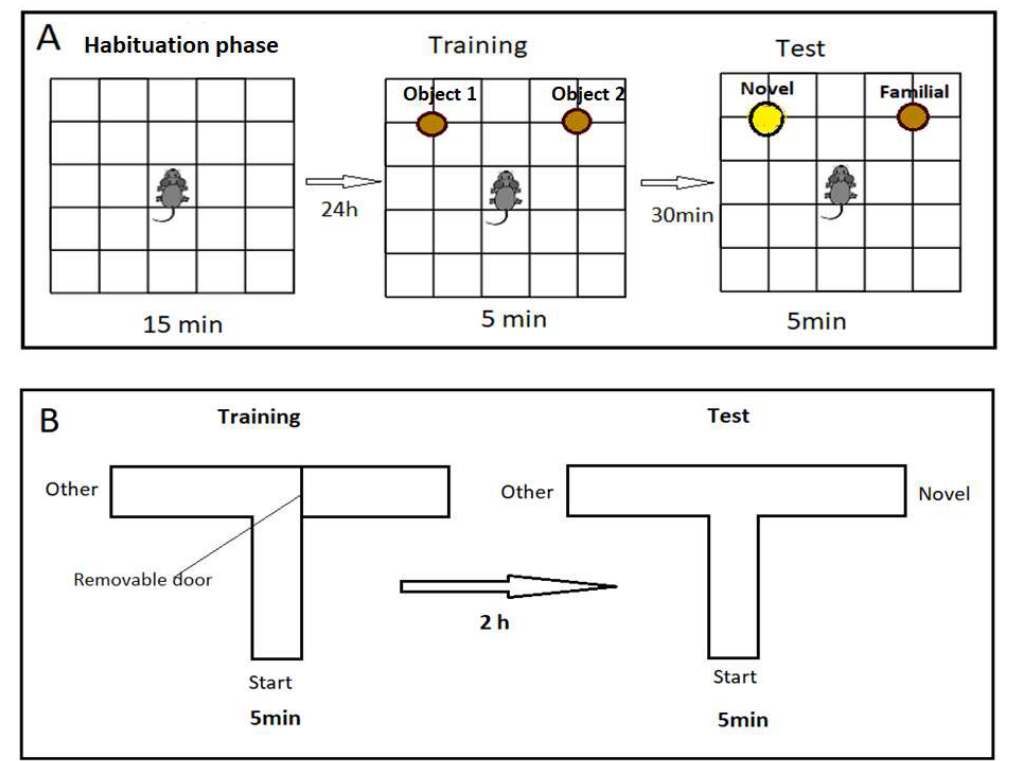
Figure 1. Schematic illustration of the different session. (A) Open field (habituation) for 15 min, training and test sessions for novel object discrimination. (B) Modified T-maze, training trial for 5 min in start and other arms. Test trial for 5 min in start, other and novel arms, 2 h interval.